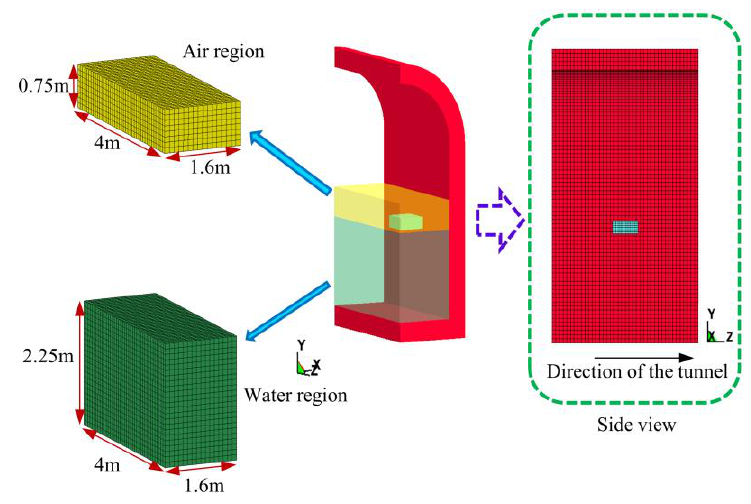
Figure 2. Fluid–solid coupling model. Figure 2. Fluid – solid coupling model. Figure 2. Fluid – solid coupling model.